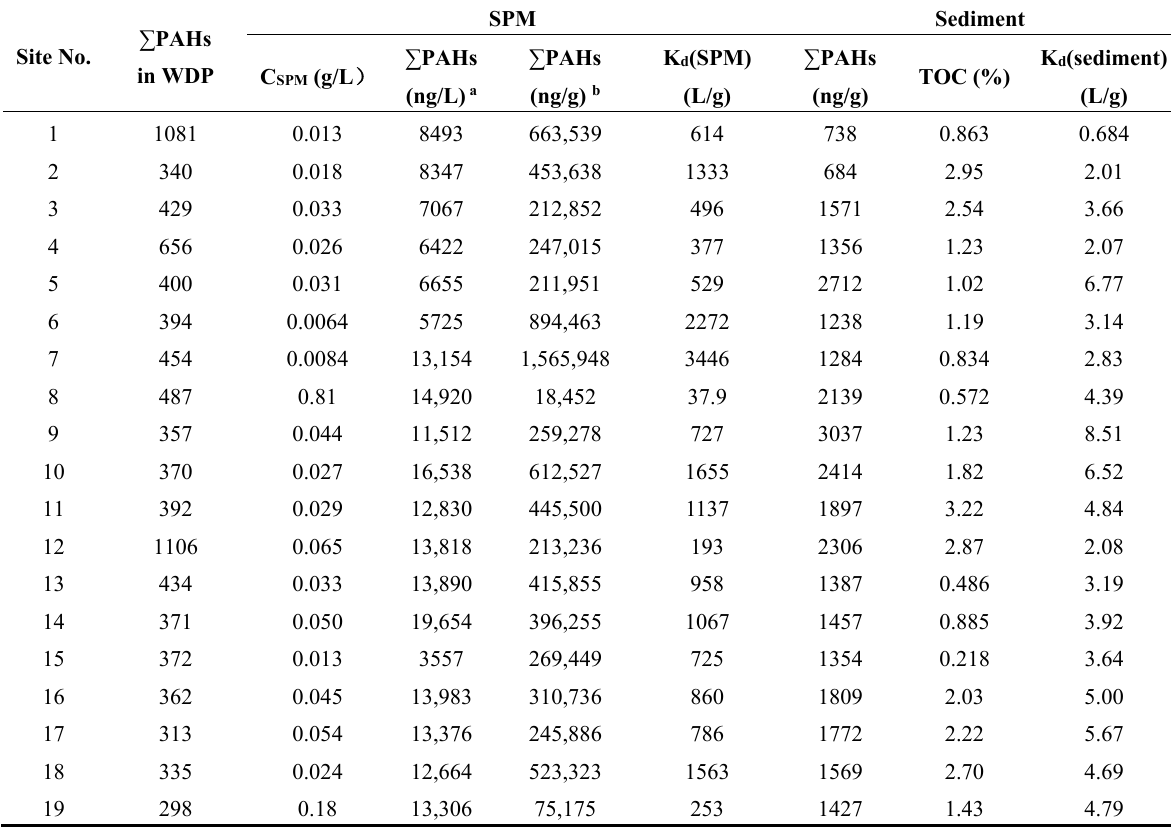
Table 3. The ∑ PAHs in SPM, TOC in sediment, the K d (SPM) and K d (sediment) in sampling sites. Site